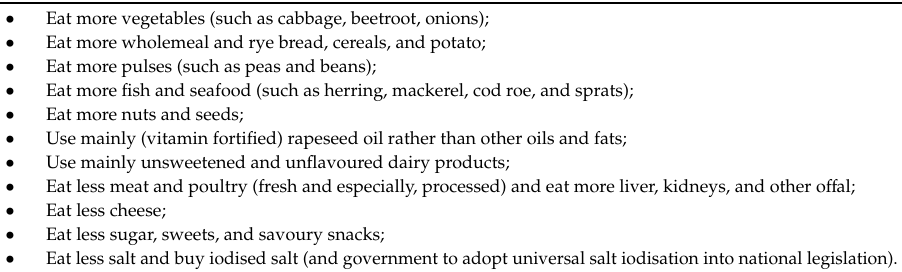
Table 7. Estonian food-based dietary guidelines for low SES families should include the following